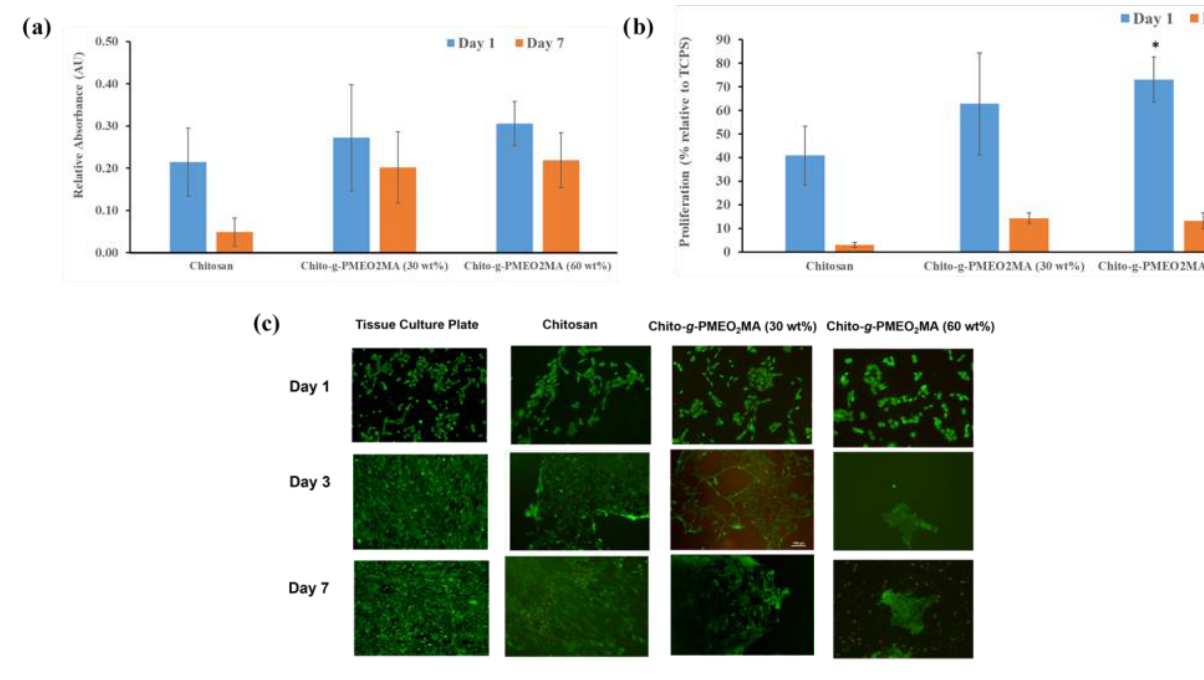
Figure 6. NIH 3T3 fibroblasts on TCPS, chitosan, and modified chitosan films. ( a ) Proliferation of NIH 3T3 cells on modified and unmodified chitosan films, relative absorbance of XTT in arbitrary units (AU). Mean ± SD, n = 4 or 5. ( b ) Proliferation of 3T3 fibroblasts on chitosan films relative to control surface (TCPS), as measured by XTT. Mean ± SD, n = 4 or 5; * indicates statistically significant from chitosan, p < 0.025. Note that statistical significance is not reported for day 7 due to the sorption of XTT into the films. ( c ) The 3T3 fibroblasts ’ viability on chitosan, Chito- g -PMEO 2 MA (30 wt %),